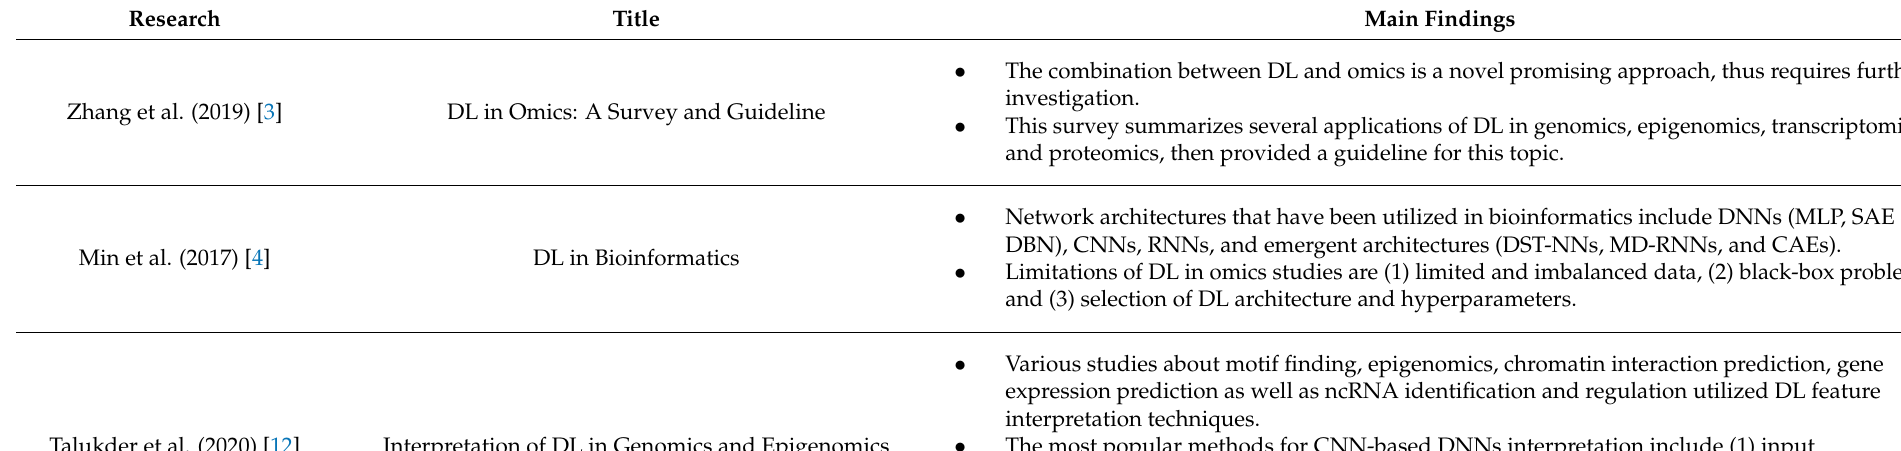
Table 1. Summary of previous reviews about DL and